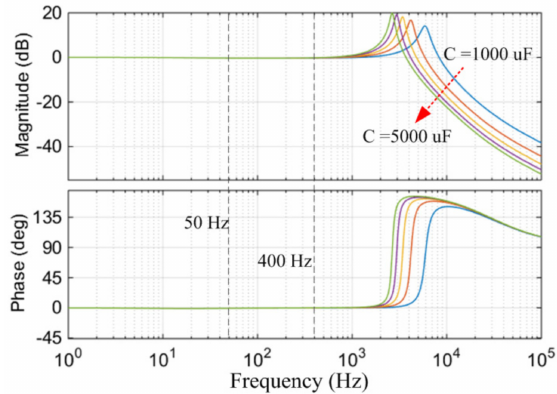
Figure A2. Bode diagram of the closed loop voltage transfer function with the increase of